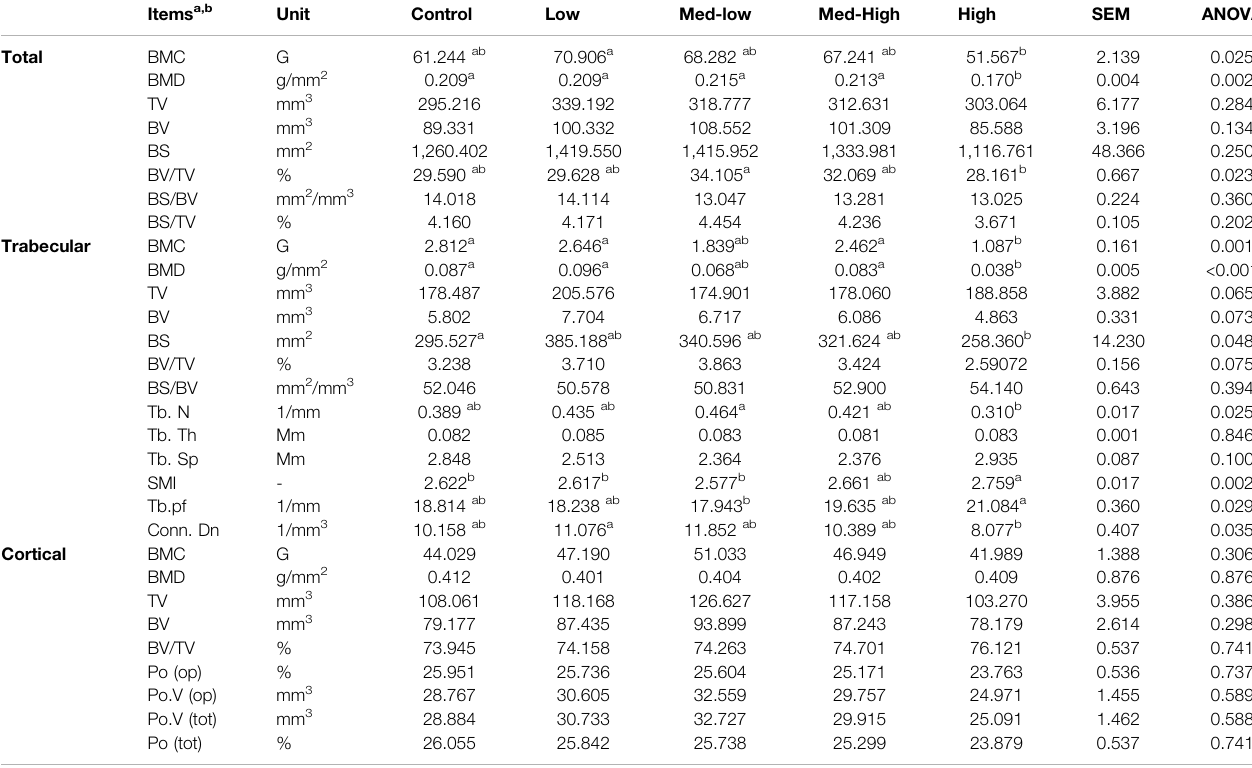
TABLE 5 | Tibial metaphysis microstructure changes with increasing challenge dose of mixed Eimeria spp. oocysts. Items